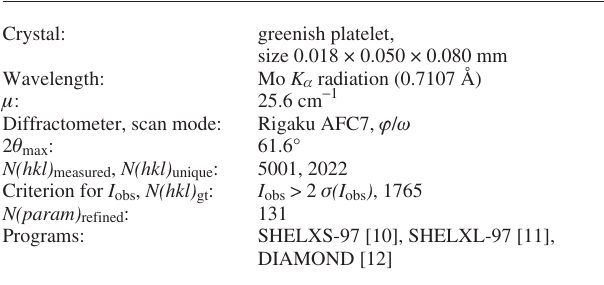
Table 1. Data collection and handling.